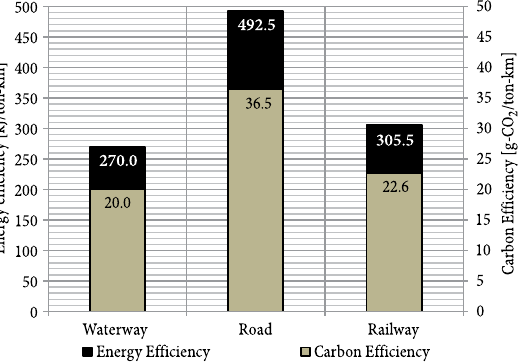
Fig. 6. Energy and carbon efficiency per mode of transport service